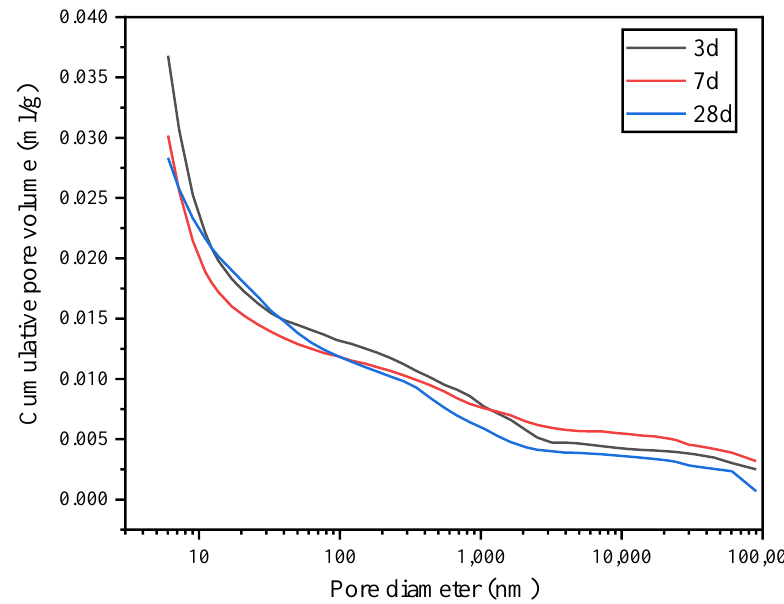
Figure 12. Cumulative pore volume of the G0 sample.